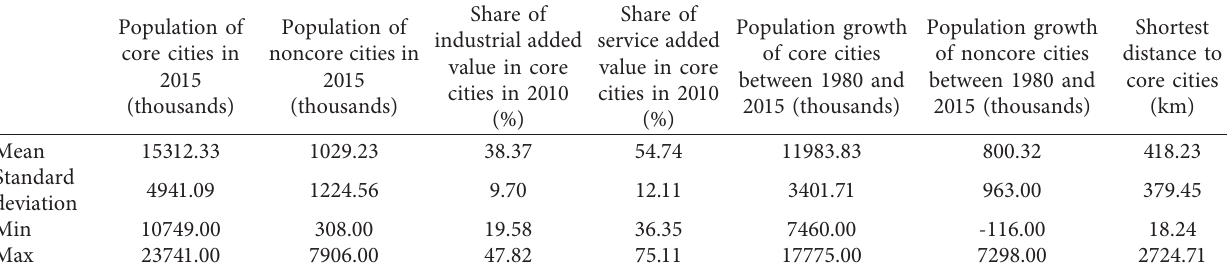
Table 3: Descriptive statistics of